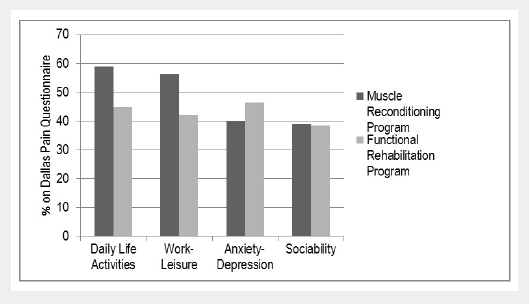
Results at follow-up for the two programmes for each of the Dallas Pain Questionnaire subscales. A difference was observed favouring the multidisciplinary functional rehabilitation programme in terms of “daily life activities” and “work-leisure” with a trend toward statistical significance.